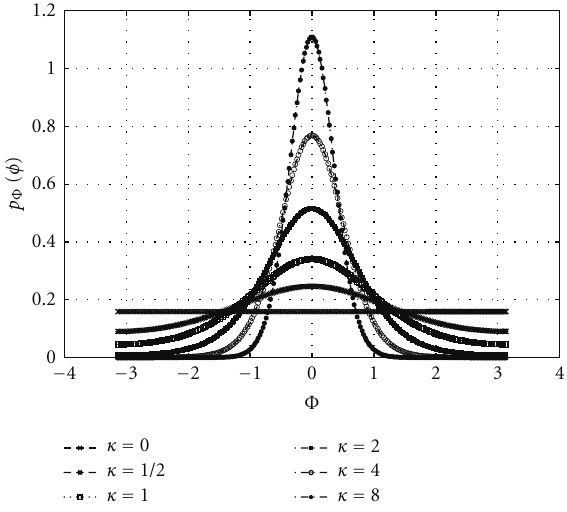
Figure 1: Von Mises distribution for several values of κ